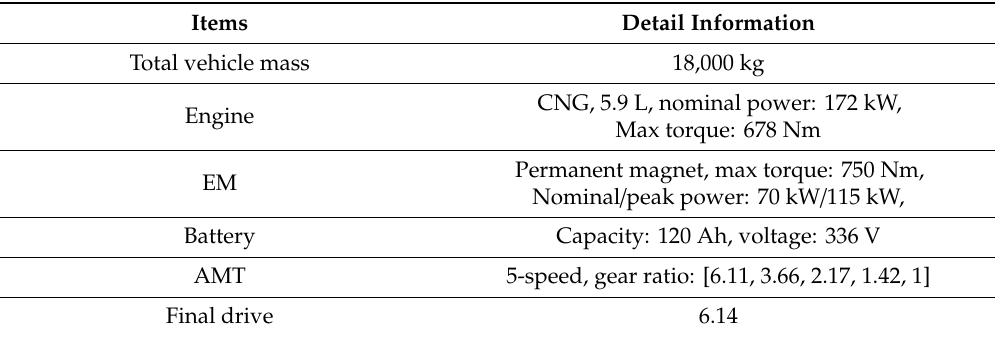
Figure 1. Configuration of the PHEV powertrain. Table 1. Parameters of PHEB.